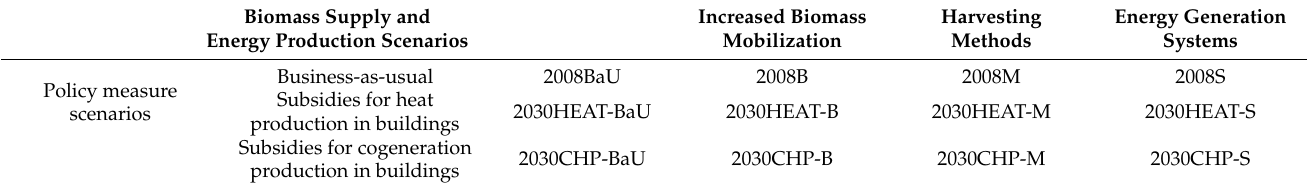
Table 2. Scenarios and acronyms used.